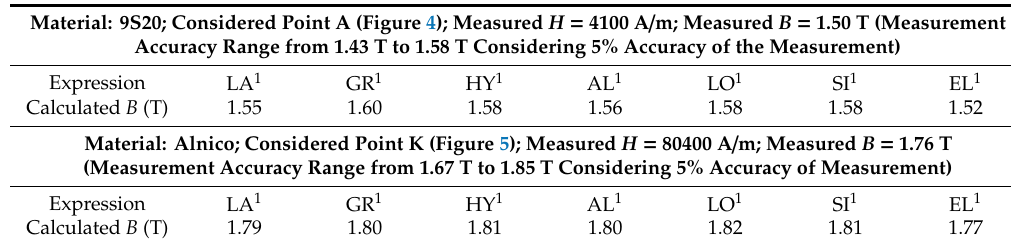
Table 9. Measured and calculated values of B at points A and K.